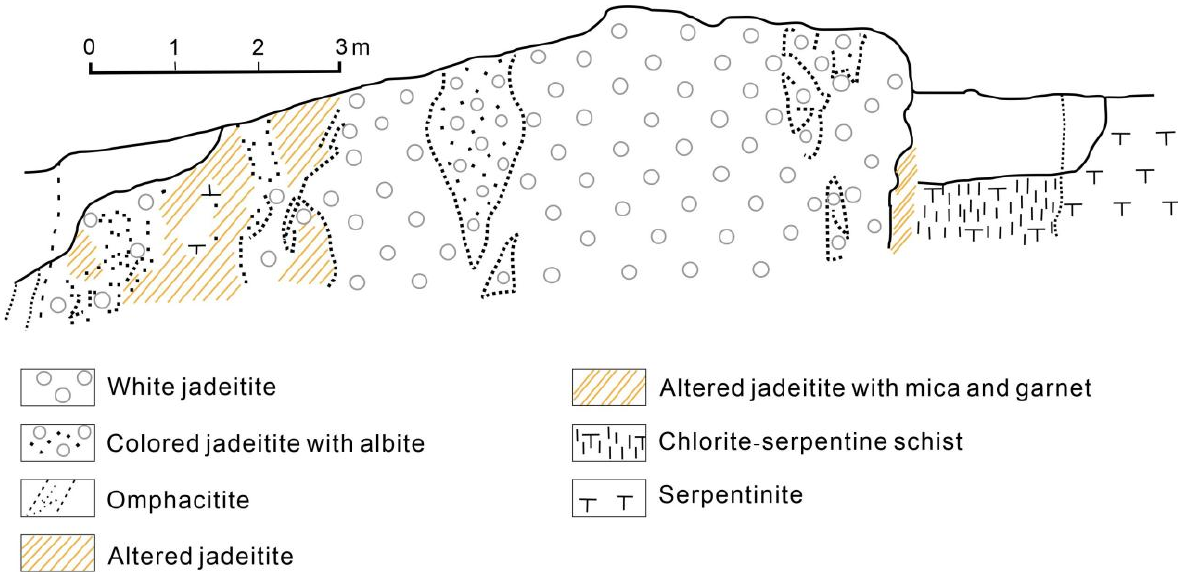
Figure 2. Cross section of Kazakhstan jadeitite in ultrama fi c rock mass (modi fi ed from [37,43]).